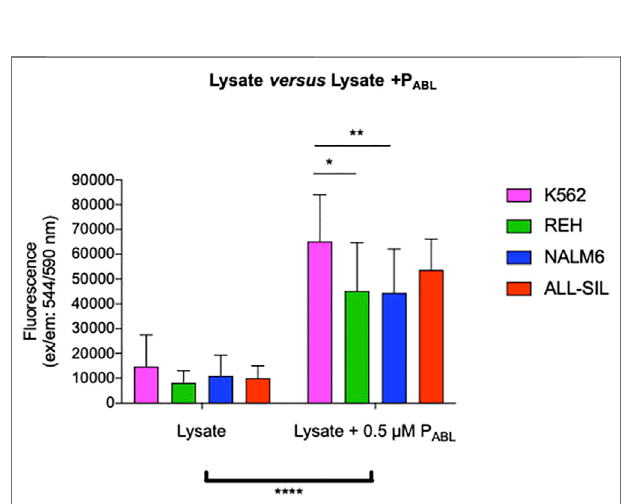
FIGURE 5 | P ABL -based ELISA assay. The graph shows data obtained from 12 independent experiments for K562, REH and NALM6 cell lines and seven experiments for the ALL-SIL cell line. Fluorescence values in ordinate. Thereisasigni fi cantincreaseintermsofphosphorylationlevelsforallthe lines after incubation with the peptide P ABL (****, p -value ANOVA two-way 0.0001).K562lineshowedthehighestsignal,signi fi cantlyhighercomparedto the NALM6 and REH ( p -value ANOVA two-way Bonferroni post-test for multiple comparison: *: 0.05; **: 0.001).